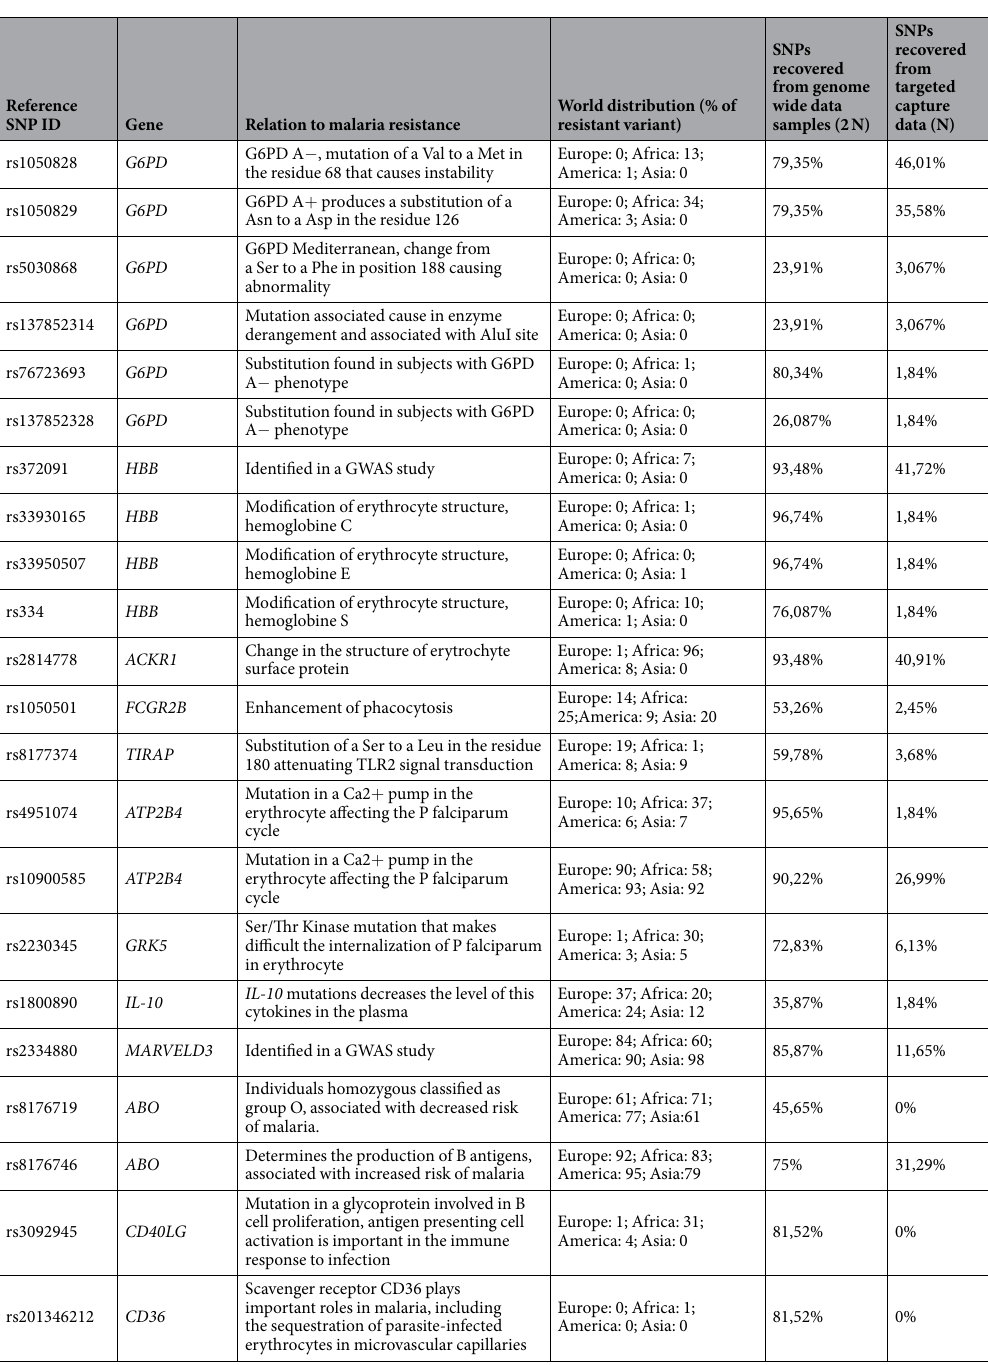
Table 1. Summary of the genetic variants analysed in the study and the hypothetical functional explanation in relation to malaria resistance, when available. The allelic frequencies have been estimated from data from the 1,000 Genomes. The recovery statistics are also presented in this